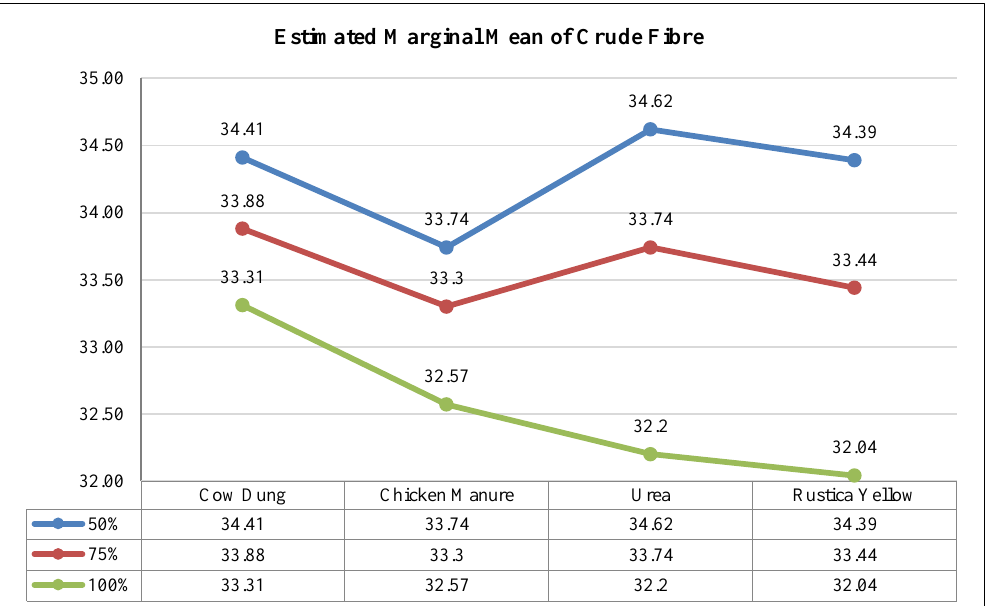
Figure 9. Nitrogen Sources' Effects and Levels on Crude Fiber